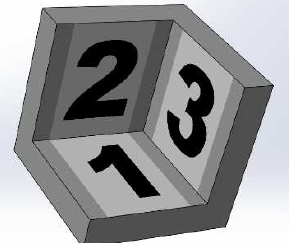
Fig. 2. Test model with 3 luminescent walls. Numbering is according to the one employed in the paper.